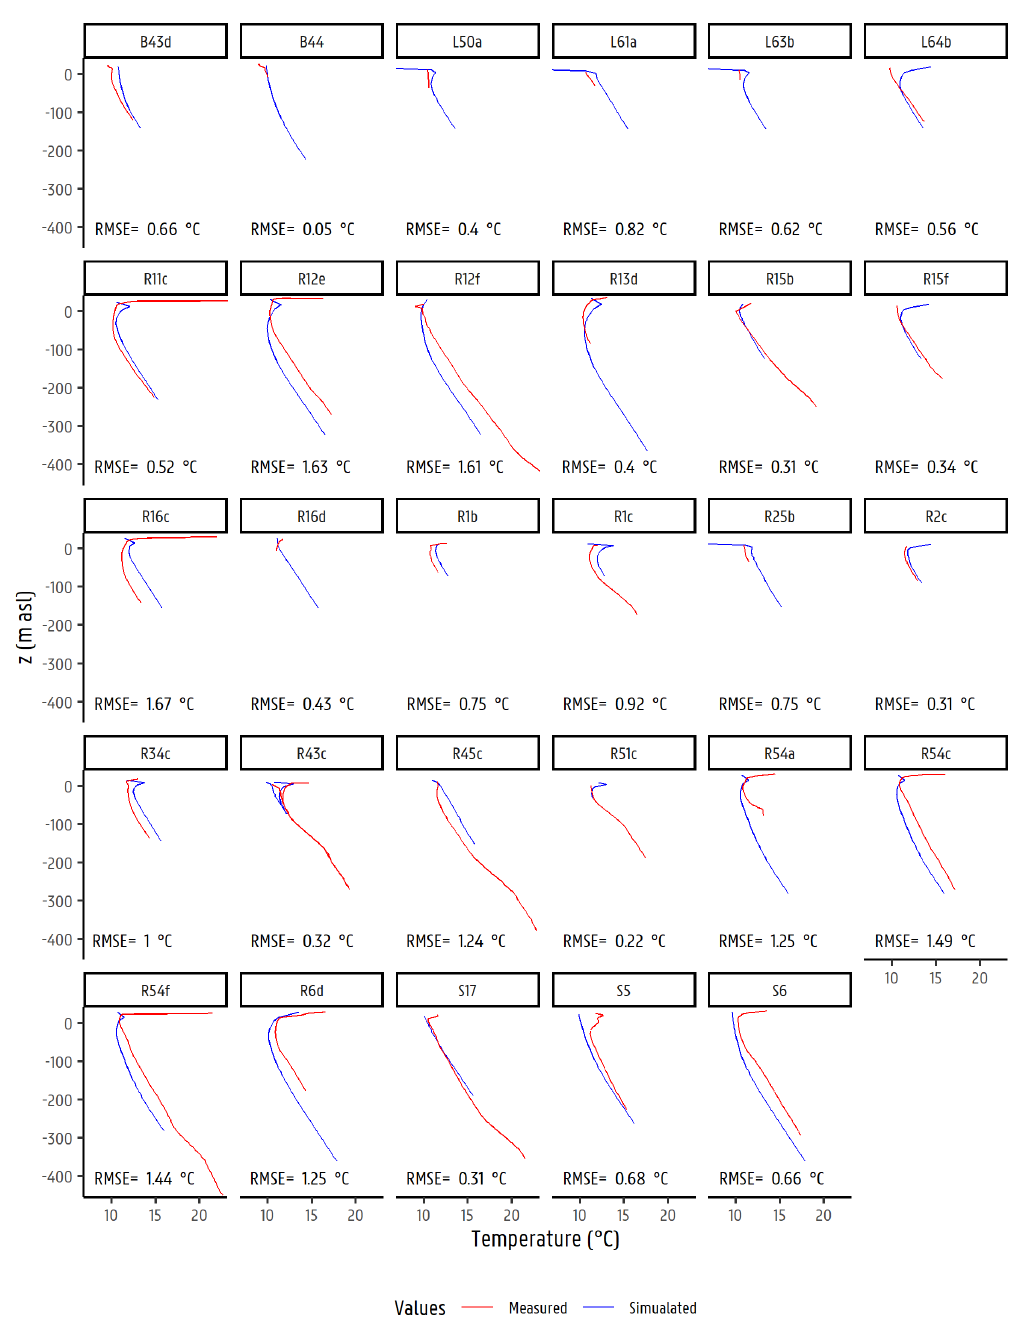
Figure A1. Measured and simulated temperature–depth profiles for all locations across the Neogene Aquifer within the Nete catchment.